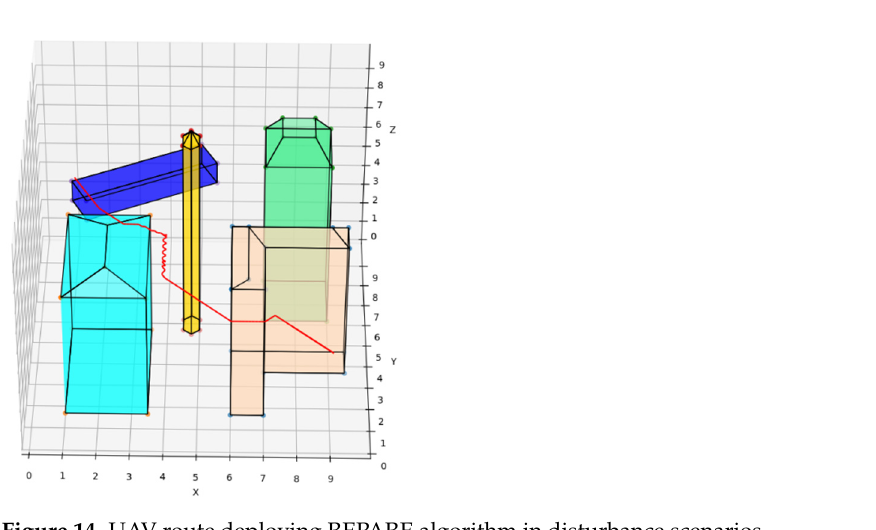
Figure 13. UAV route deploying traditional artificial potential field route planning algorithms in disturbance scenarios.